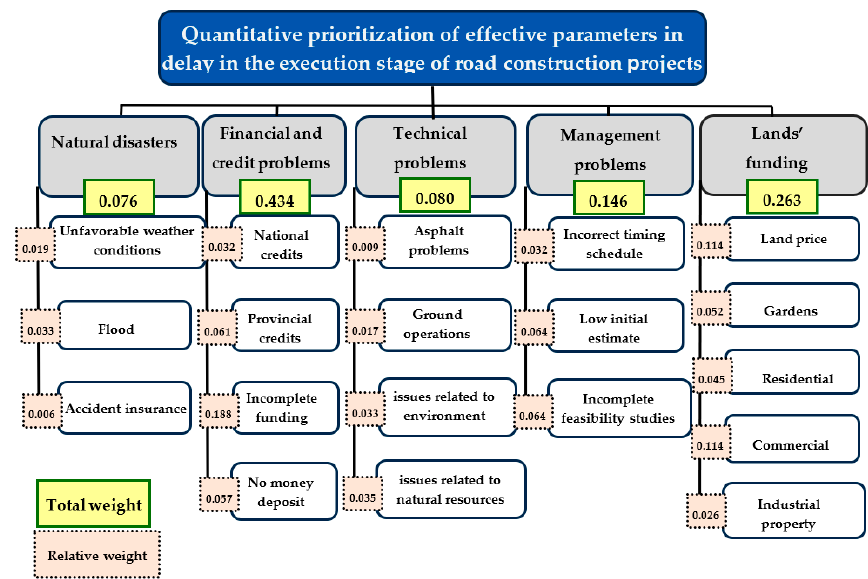
Figure 3. The relative and total weight of the criteria and subcriteria.